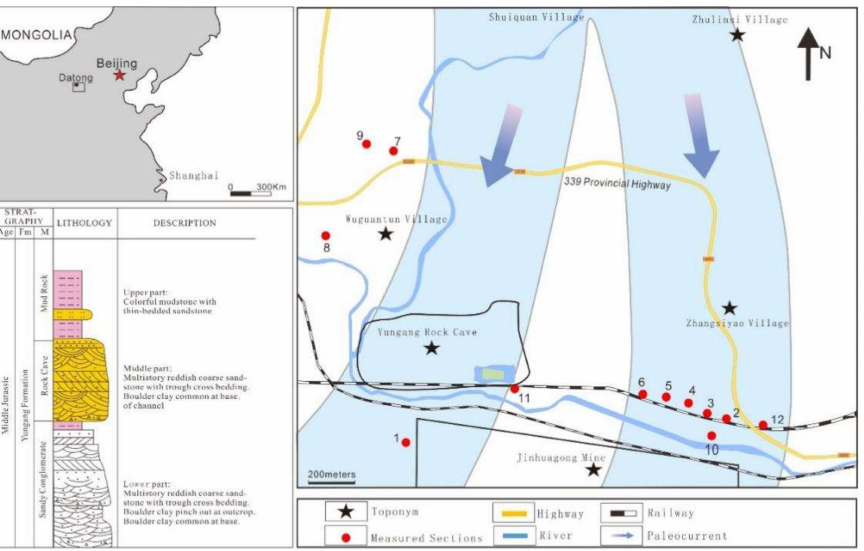
Figure 1. Location of Datong Basin, the regional geological background of outcrop and lithologic column of exposed Rockcave Member